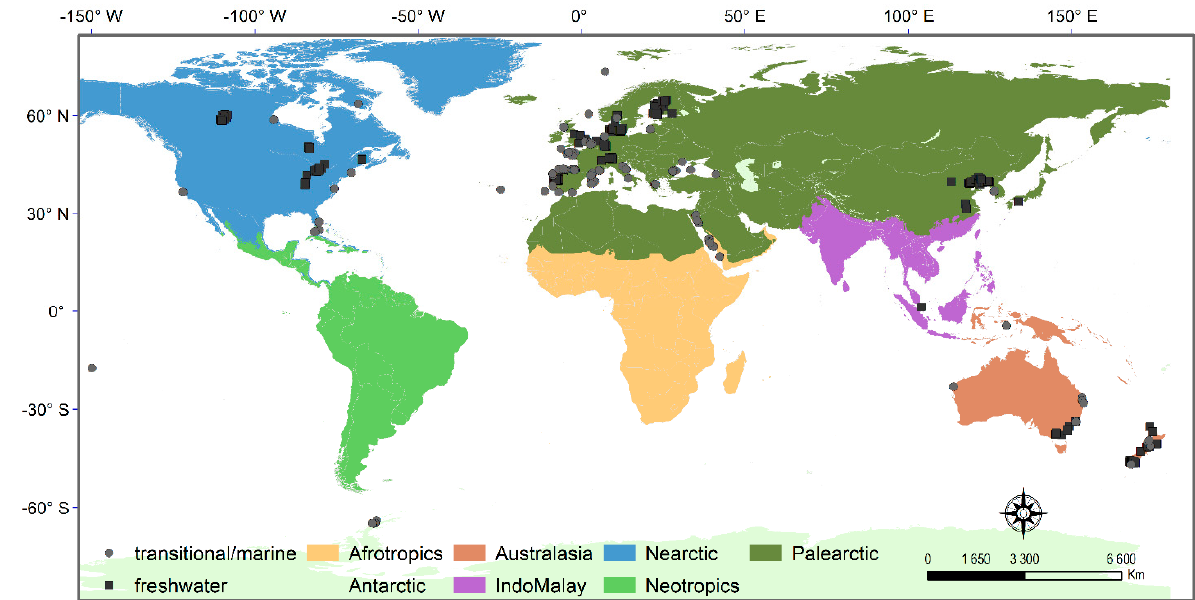
Figure 2. Map showing the distribution of the studies reviewed here; each site is represented by a dot, with colors indicating the biogeographical region.